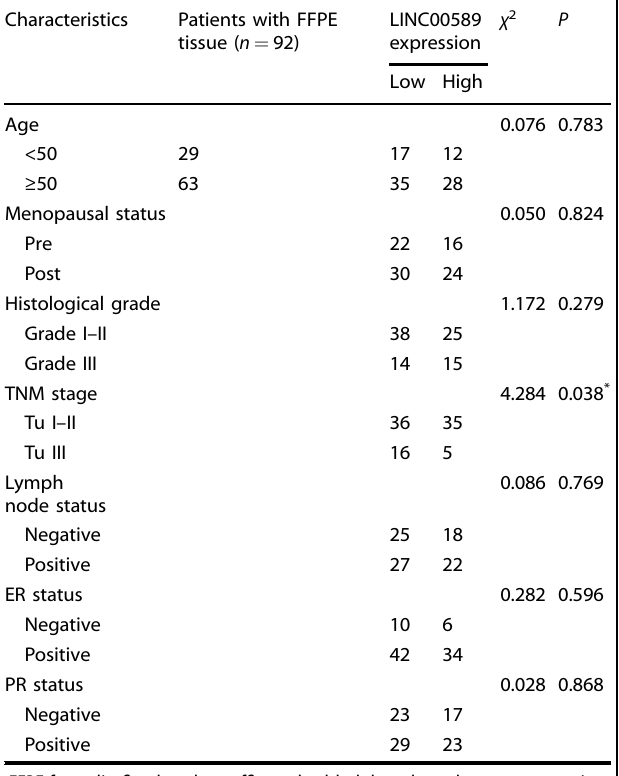
FFPE formalin- fi xed and paraf fi n-embedded, lymph node status: negative, number of nodal metastases ≤ 3; positive, number of nodal metastases >3, ER estrogen receptor, PR progesterone receptor. The χ 2 test was used to compare percentages or the association between LINC00589 and clinicopathological parameters. * P <0.05